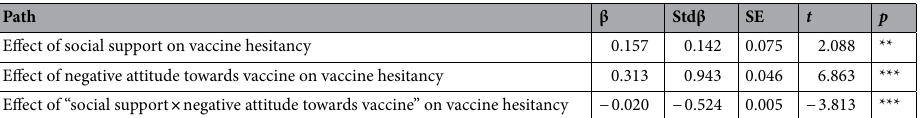
Table 8. The moderating effect of social support on the relationship between negative attitude towards vaccine and vaccine hesitancy. Social support—moderating variable; negative attitude towards vaccine—one of the TPB dimensions; β—unstandardised beta co-efficient; Stdβ—standardised beta co-efficient; SE—standard error; t—t value, p —shows the significant level; All parameters obtained from the AMOS output. *** p < 0.001; ** p < 0.05.